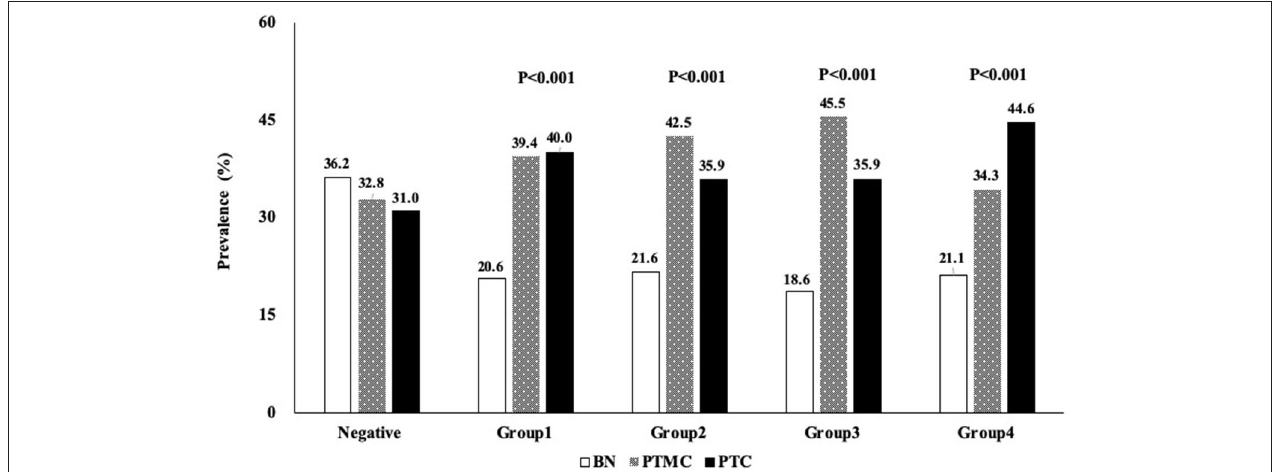
FIGURE 2 | Profile showing the percentage distribution of 4 groups of patients with different serum TgAb titer who were diagnosed with BN, PTMC, or PTC. BN, benign; PTC, papillary thyroid cancer; PTMC, papillary thyroid microcarcinoma; TgAb, anti-thyroglobulin antibody.